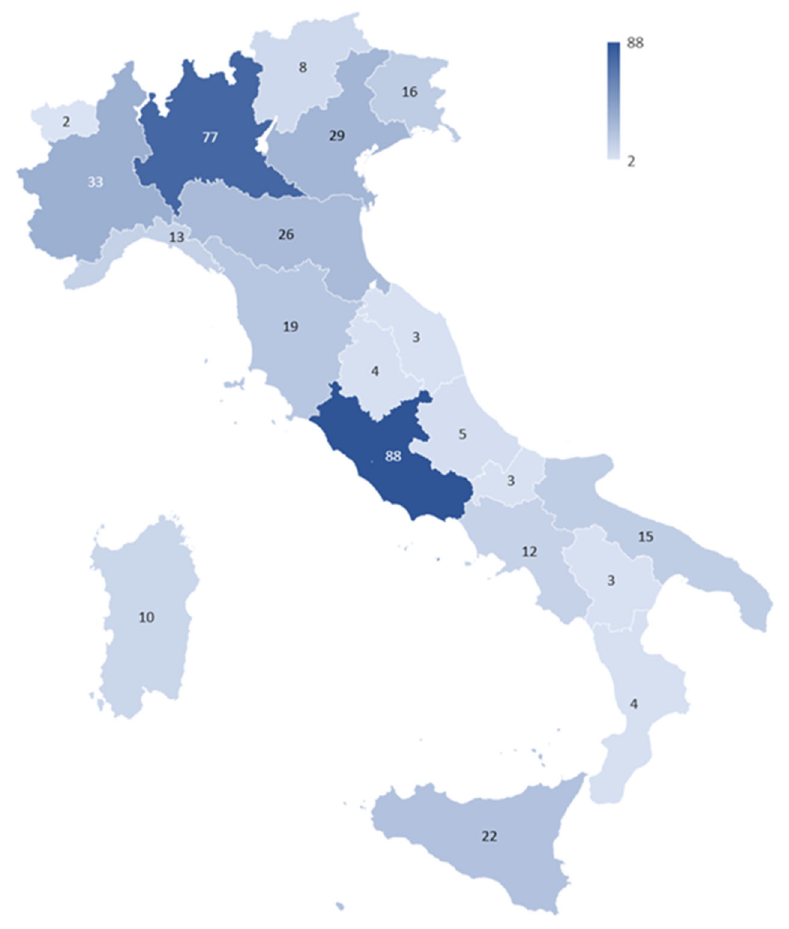
Figure 1. Graphical representation of the survey participants distribution among Italian regions. The regions with the darkest color represent those with the greatest number of participants.